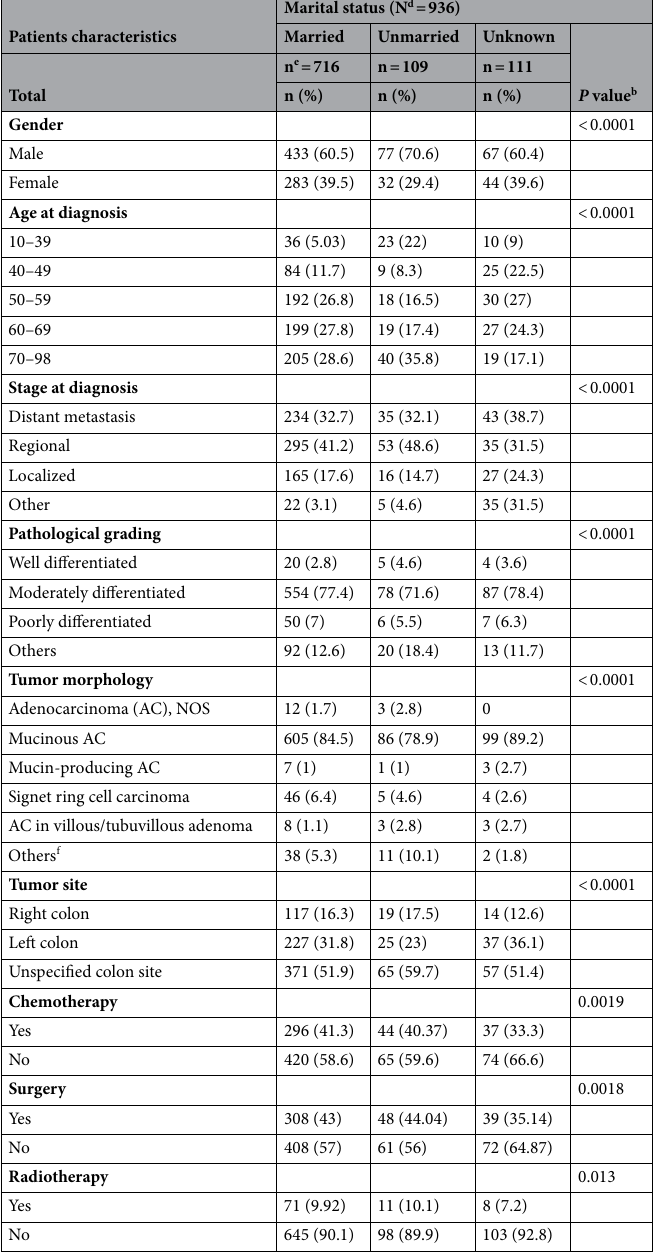
Table 1. Demographic, clinical and pathological characteristics of saudi’s colorectal cancer patients at MNG-HA (2009–2017) a . a Data represent Saudi patients registered in MNG-HA hospitals system between January 1 2009 and December 31 2017. b P values refer to comparisons between marital status groups using Fisher exact test. c P values refer to comparisons between marital status groups using Fisher exact test. d "N" total sample size. e "n" sample size for each group. f Other categories for morphology with small number of